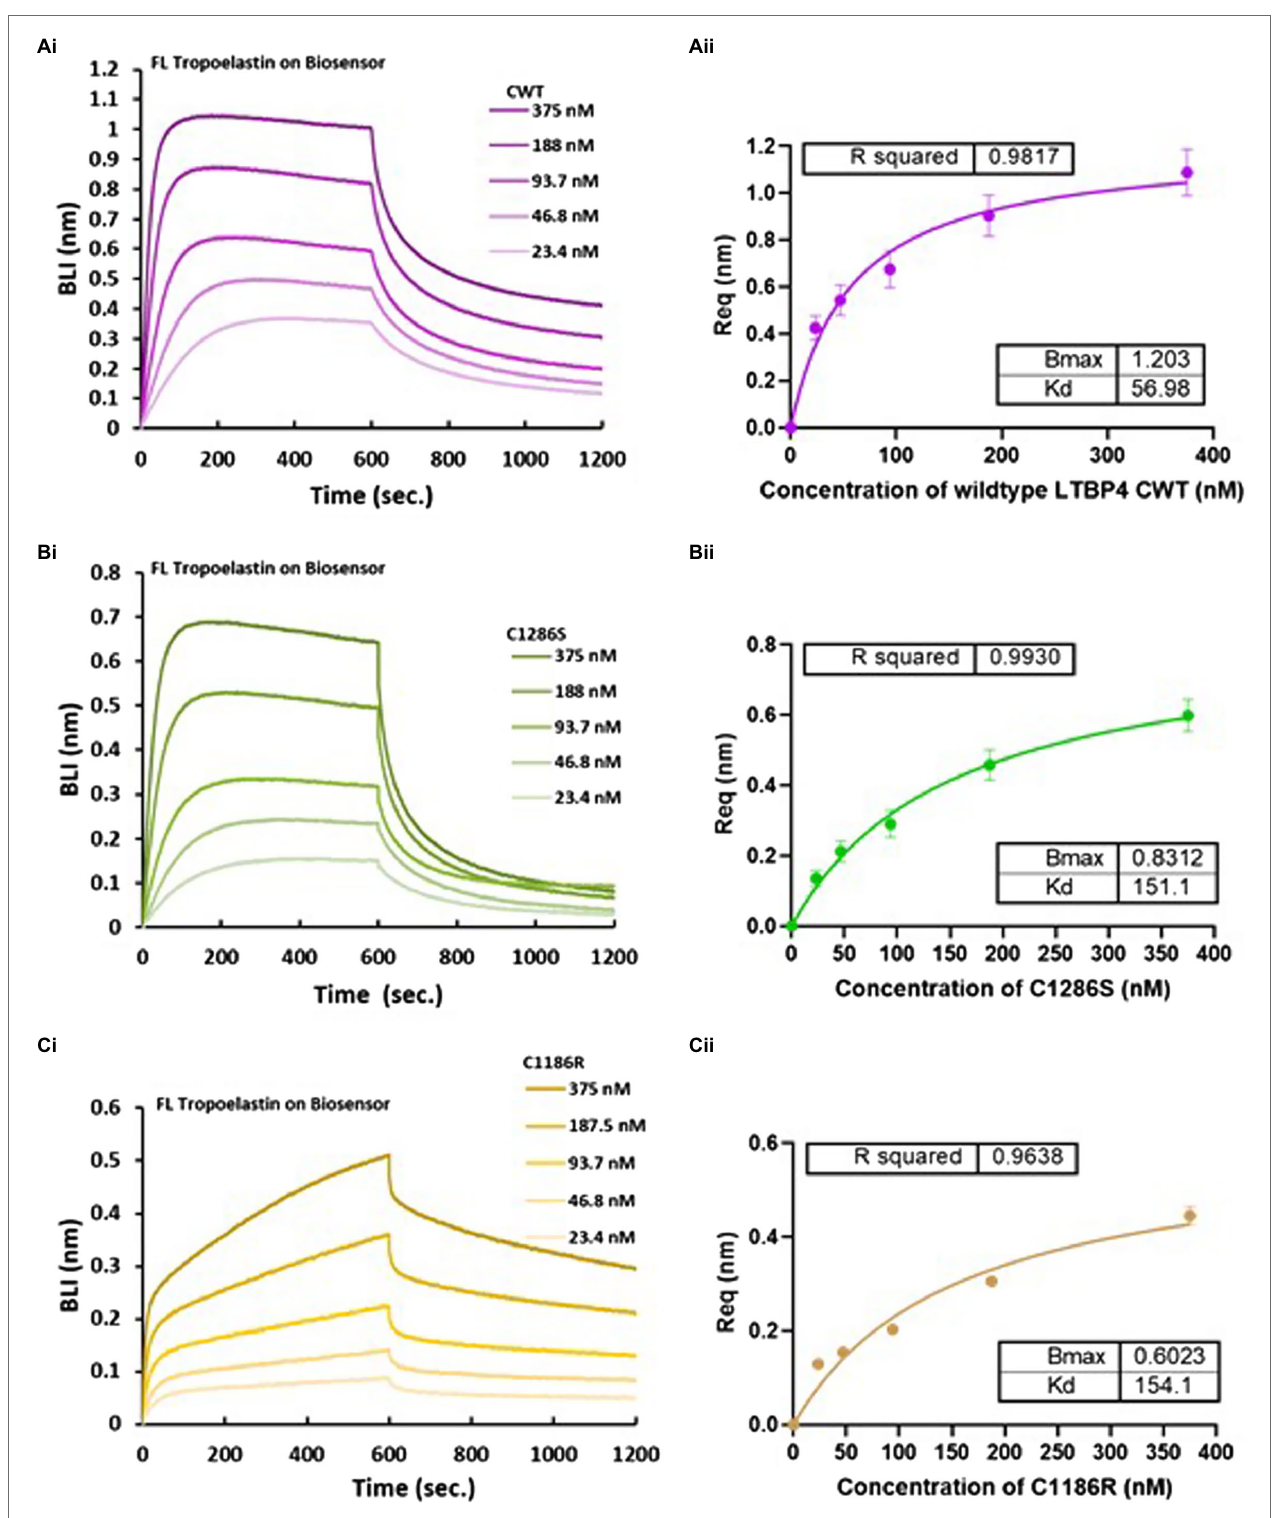
FIGURE 5 | Biolayer interferometry (BLI) analysis of LTBP4CT binding to full-length tropoelastin. OctetRED analysis shows that LTBP4 (A) CWT, (B) C1286S and (C) C1186R at different concentrations (375–23.4 nm) directly bind to immobilised full-length tropoelastin. The binding affinity was determined by steady state analysis (equilibrium) plotted against (A) (ii) CWT, (B) (ii) C1286S and (C) (ii) C1186R concentration. All experiments were performed in at least duplicate and averaged KD in nm are presented. Error bars represent standard